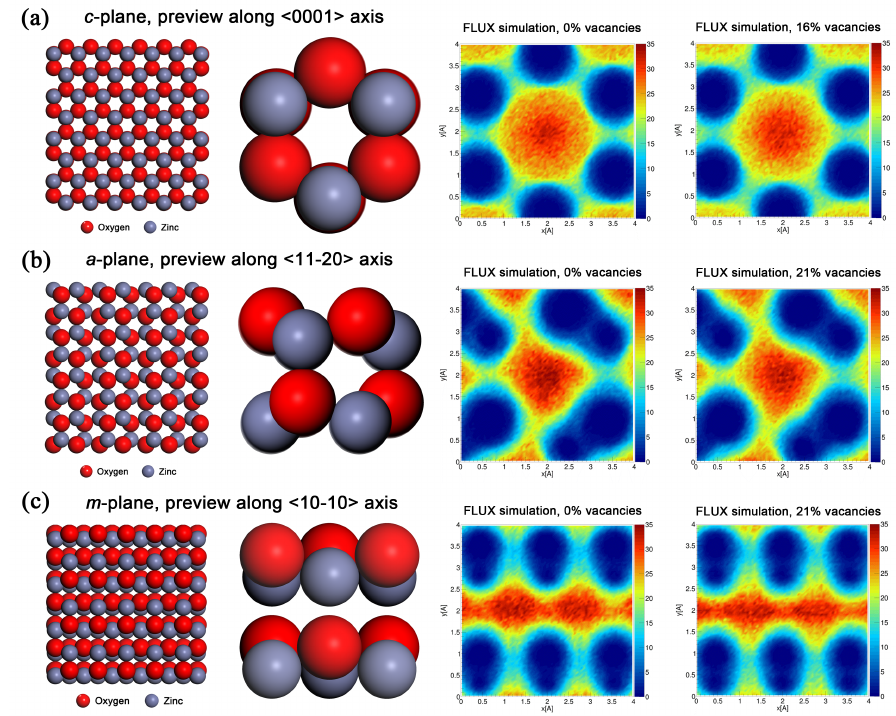
Figure 3. The crystal–structure models of various ZnO cuts are visualized on the left: ( a ) (0001) c -plane, ( b ) (11–20) a -plane and ( c ) (10–10) m -plane. The right side shows the FLUX simulation of the intensity of a 2 MeV He + ion beam transmitted through a perfect ZnO crystal with various crystallographic orientations for pristine samples and for samples with introduced relative damage (measured by RBS / C) in the form of Zn vacancies. The simulation was set according to 0.4 MeV Au + ion implantation